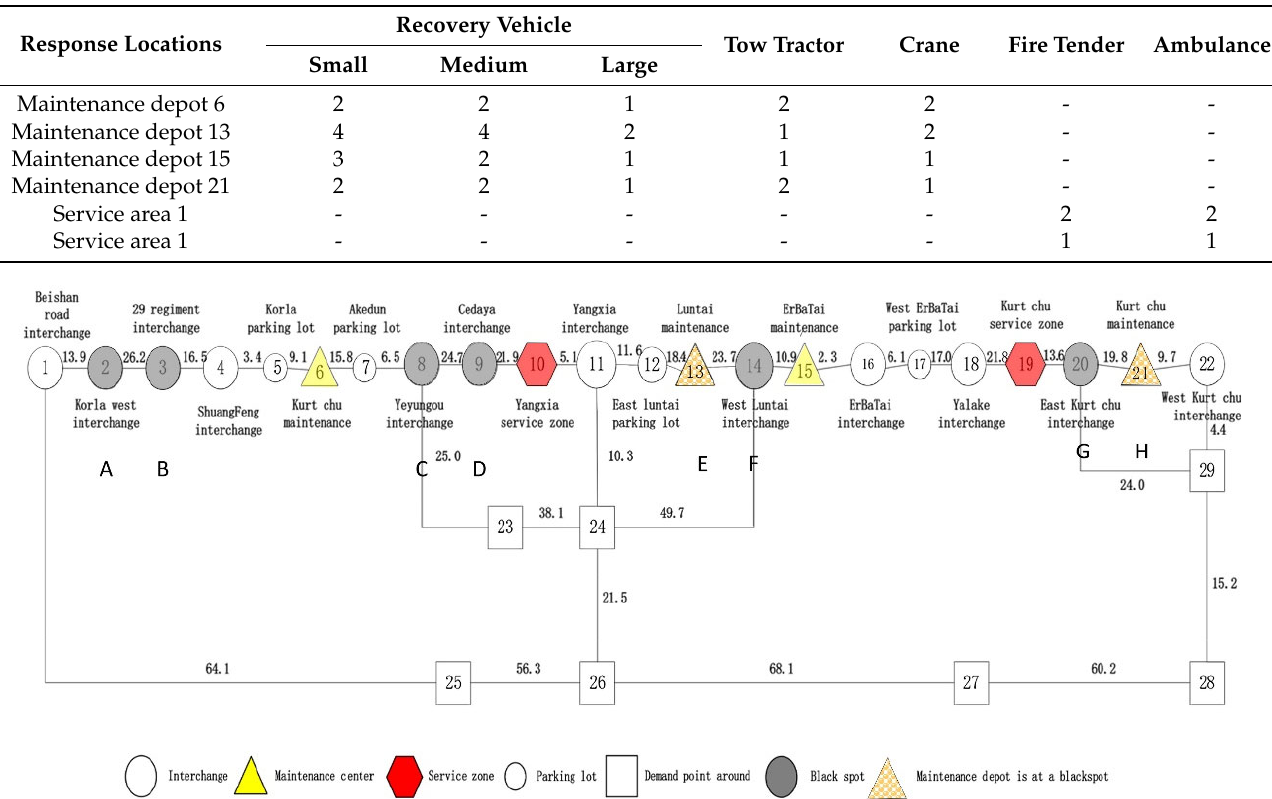
Figure 6. Regional road network showing resource allocation.